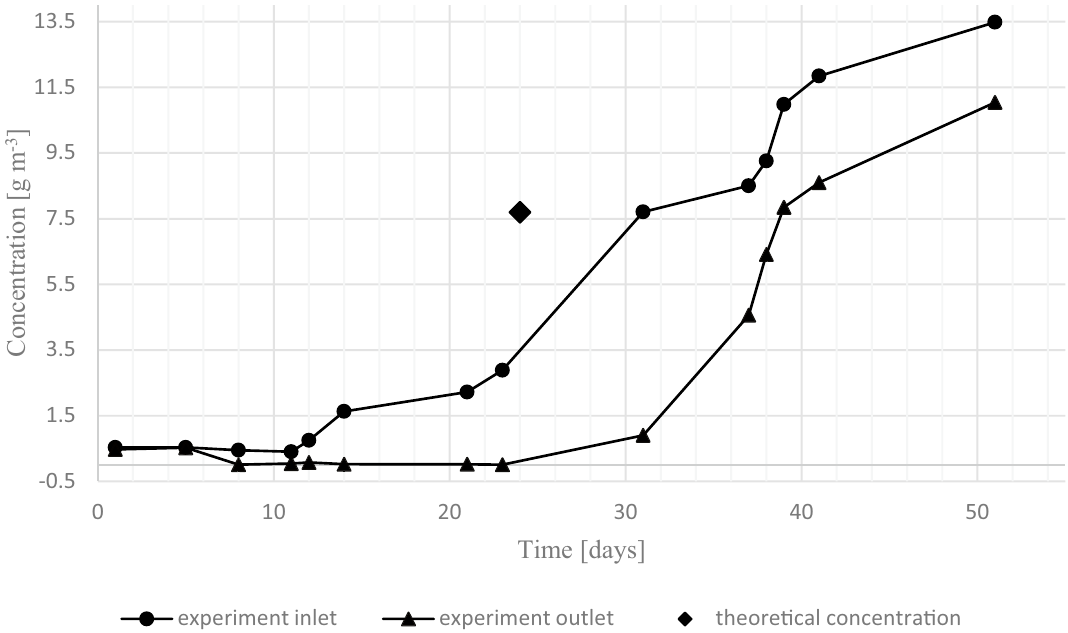
Figure 1. Experimental results of toluene biofiltration in conditions designed to yield two steady states (EBRT = 4.5 min). The single data point depicted as a rhomboid, represents the theoretical increase in the biofilter inlet after increasing the inlet concentration; i.e., it marks the time when the inlet concentration was changed to the level measured on day